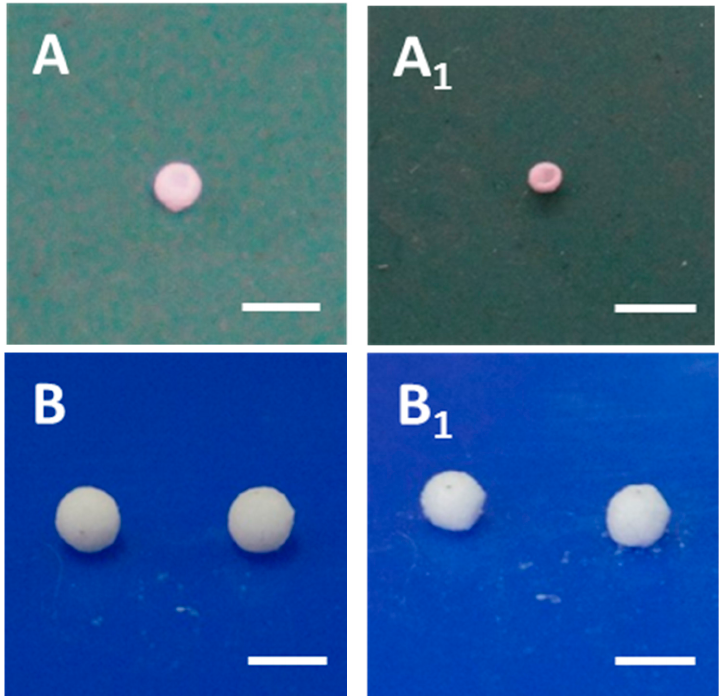
Figure 2. Digital photographs of prepared liquid marbles: ( A ) liquid marble directly deriving from PLLA solution; ( A 1 ) the formed capsule after the vaporization of dichloromethane; ( B ) Pickering emulsion marbles; ( B 1 ) the formed cellular capsule after the vaporization of both oil and water phase. All scale bars show 3 mm.